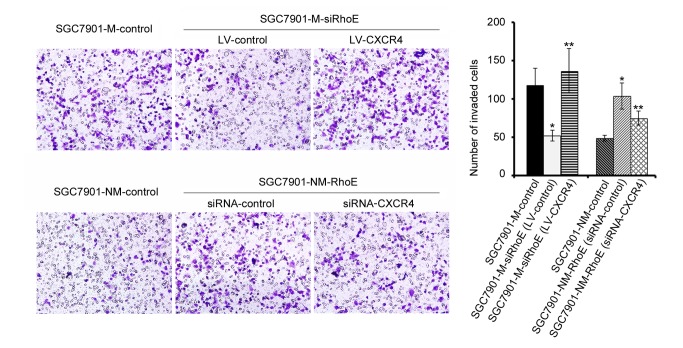
RhoE induced metastasis of gastric cancer cells was mediated by CXCR4.The influence of CXCR4 on RhoE induced metastasis was measured by a transwell assay. In SGC7901-M-siRhoE cells, CXCR4 was enhanced following lentivirus infection. In SGC7901-NM-RhoE cells, CXCR4 was knocked out by treatment with siRNA interference. The number of invading cells was determined and presented as bar charts. *P <0.05, in comparisons between the cell-lines exhibiting different levels of expression of RhoE. **P <0.05, in comparisons between cell-lines displaying differential levels of expression of CXCR4.